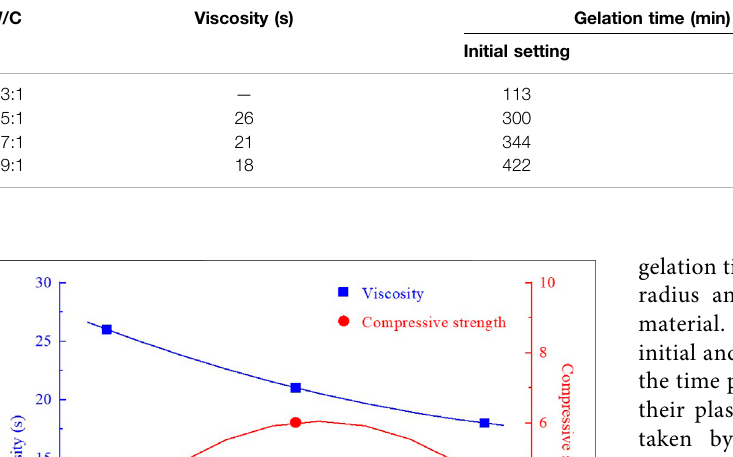
TABLE 1 | Test results of cement grout and cemented coal bodies under different water – cement ratios.